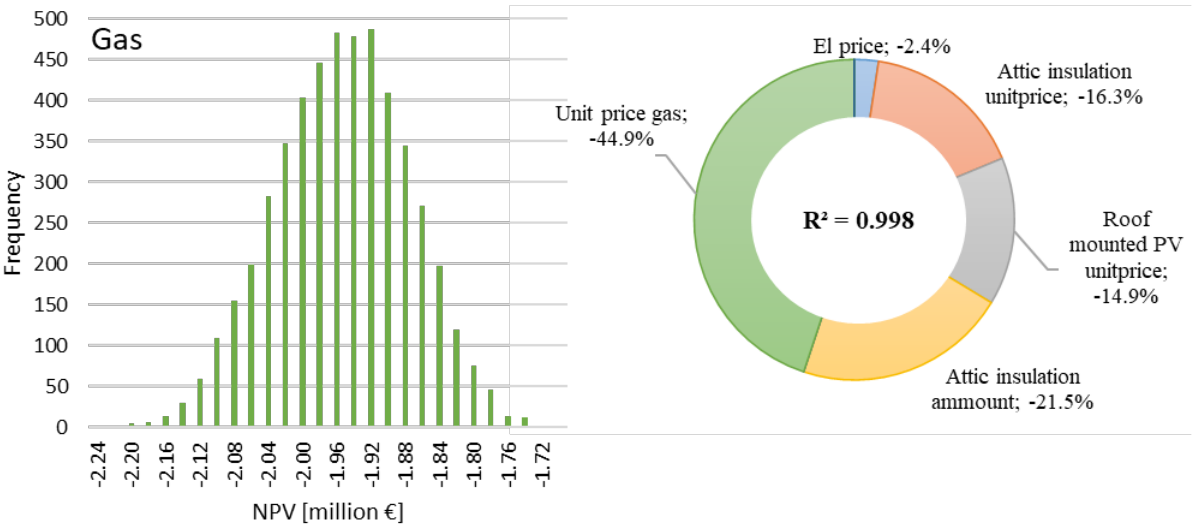
Figure A2. Left: histogram representation of resulting NPV for gas. Right: resulting share of regression coefficients and R 2 value of the linear approximation.